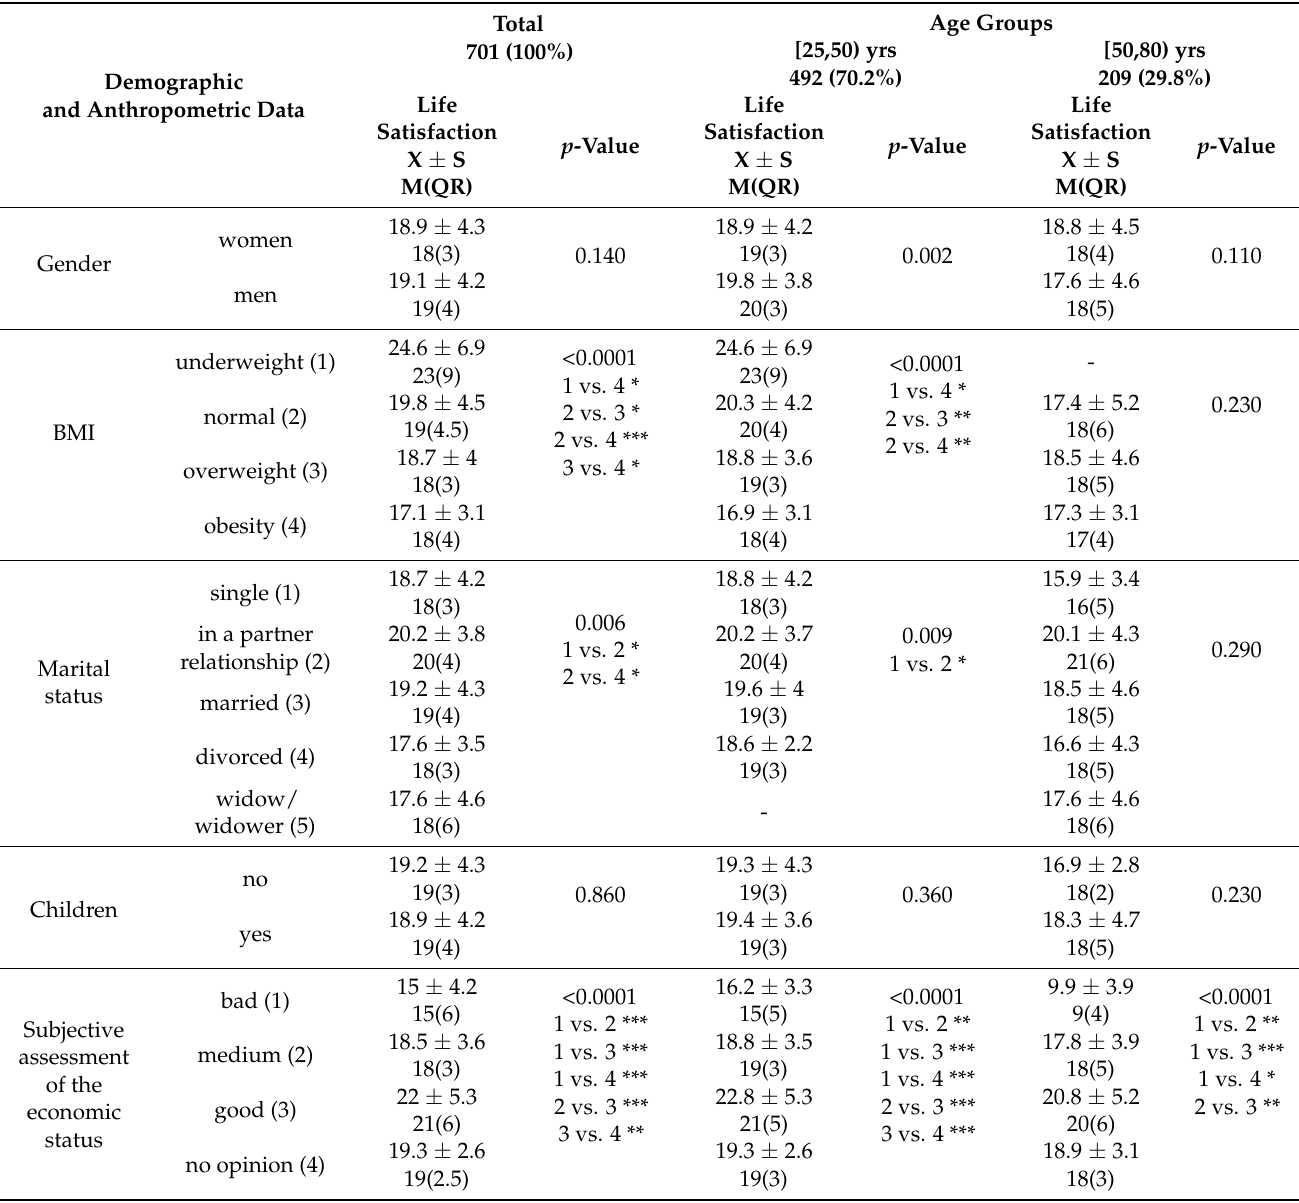
Table 1. Influence of demographic, anthropometric and socioeconomic data on the level of life satisfaction among